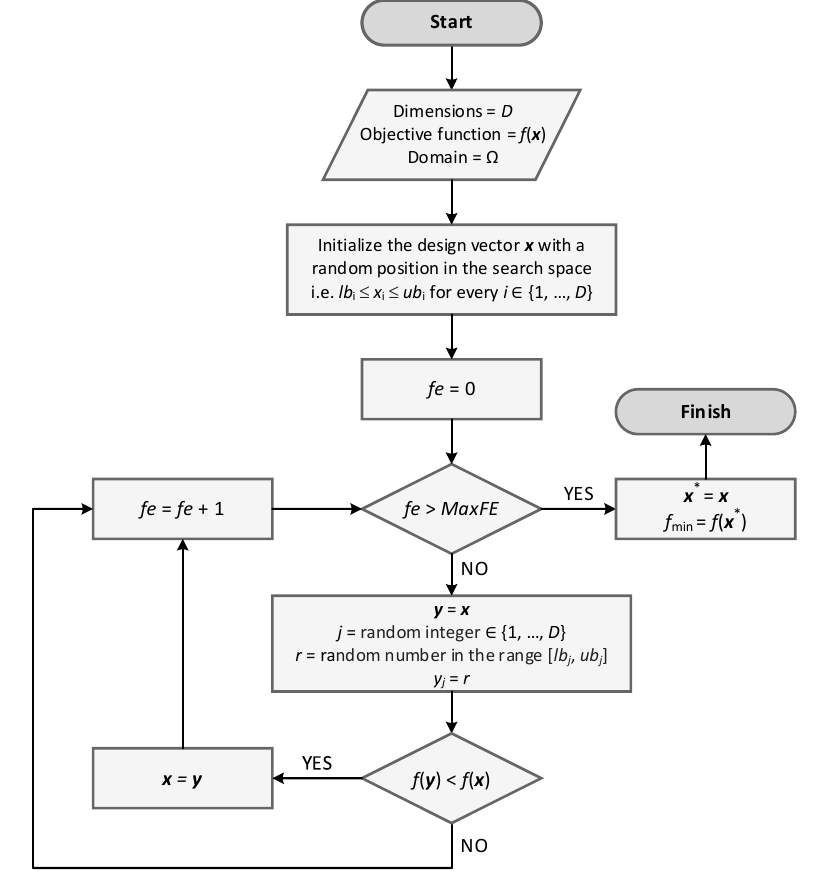
Figure 1. Flowchart of the PROS algorithm.